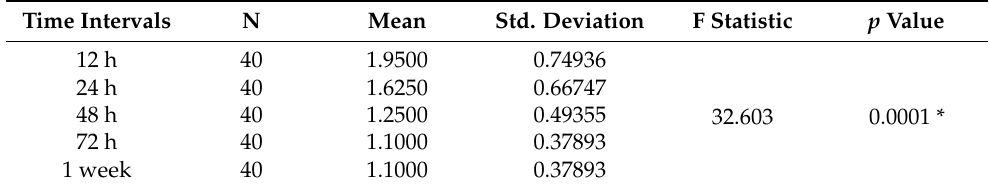
Table 6. VAS readings in Group 1 across time